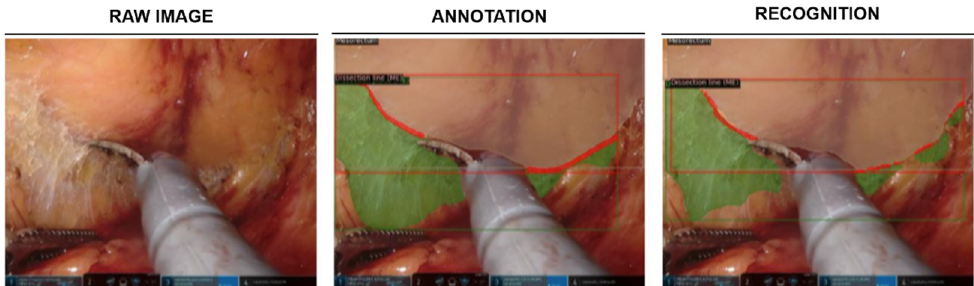
Figure 2. Machine learning-based identification of anatomical structures and dissection planes during TME. Example image displays the mesorectum (light brown), dissection plane (green), and dissection line (red). Figure modified from [53].